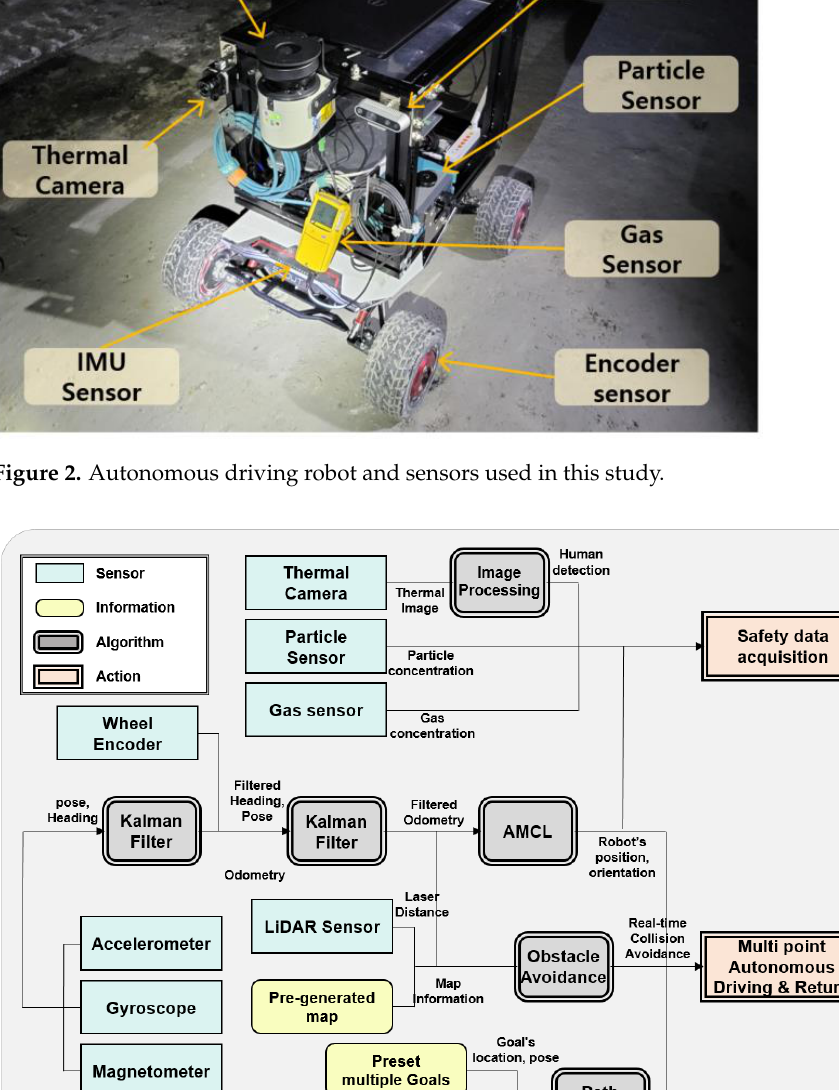
Figure 3. System architecture of the data processing procedure for the autonomous driving robot